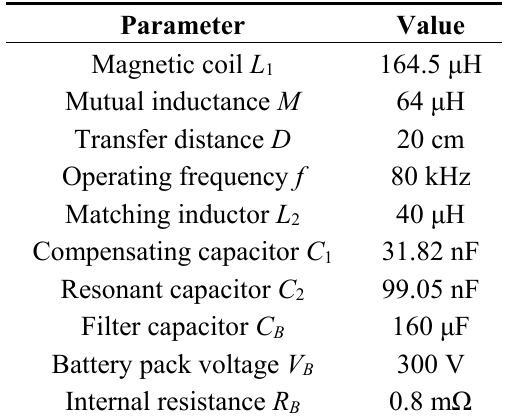
Table 2. Specific parameters in the state space